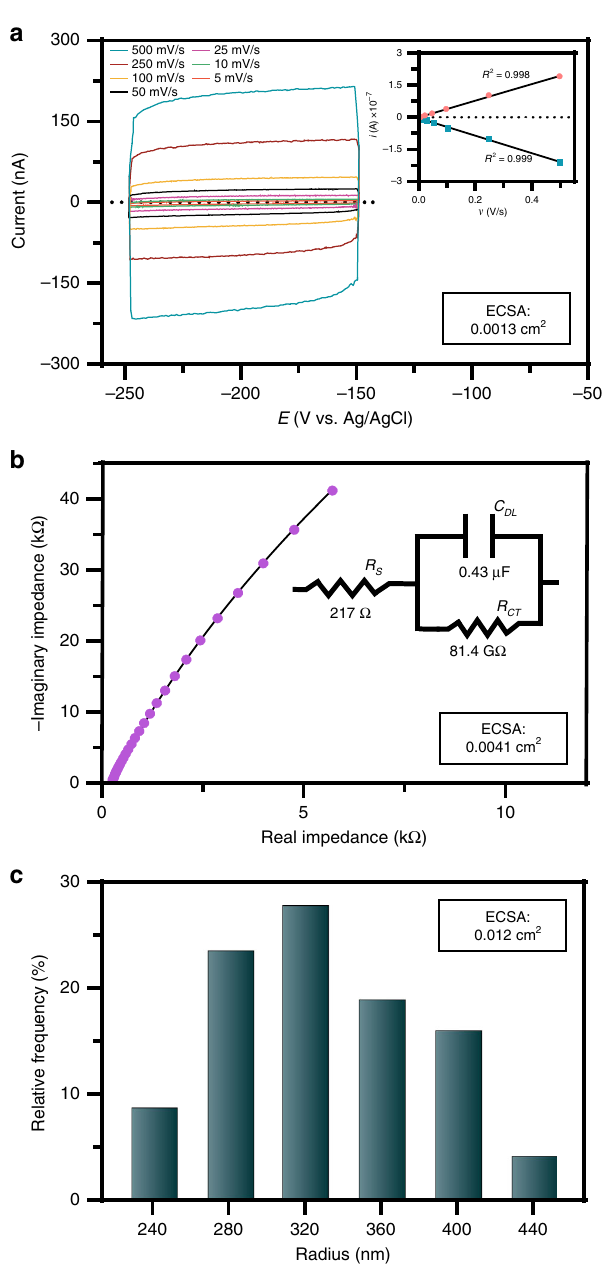
Fig. 3 Evaluation of catalyst electrochemically active surface area. a CV analysis on the CoFeLaNiPt HEMG-NP electrocatalyst from − 0.05 V to 0.05 V vs. OCP ( − 0.25 to − 0.15 V vs. Ag/AgCl) at 5, 10, 25, 50, 100, 250, and 500 mV/s in 0.1 M KOH. The inset plot shows the cathodic and anodic current contributions as a function of scan rate. b Nyquist plot obtained by EIS fi tted to the Randles cell (inset). c Histogram of observed HEMG-NP radius in SEM. The background capacitance of the bare HOPG electrode was subtracted from the obtained double layer capacitance to compensate for the low substrate